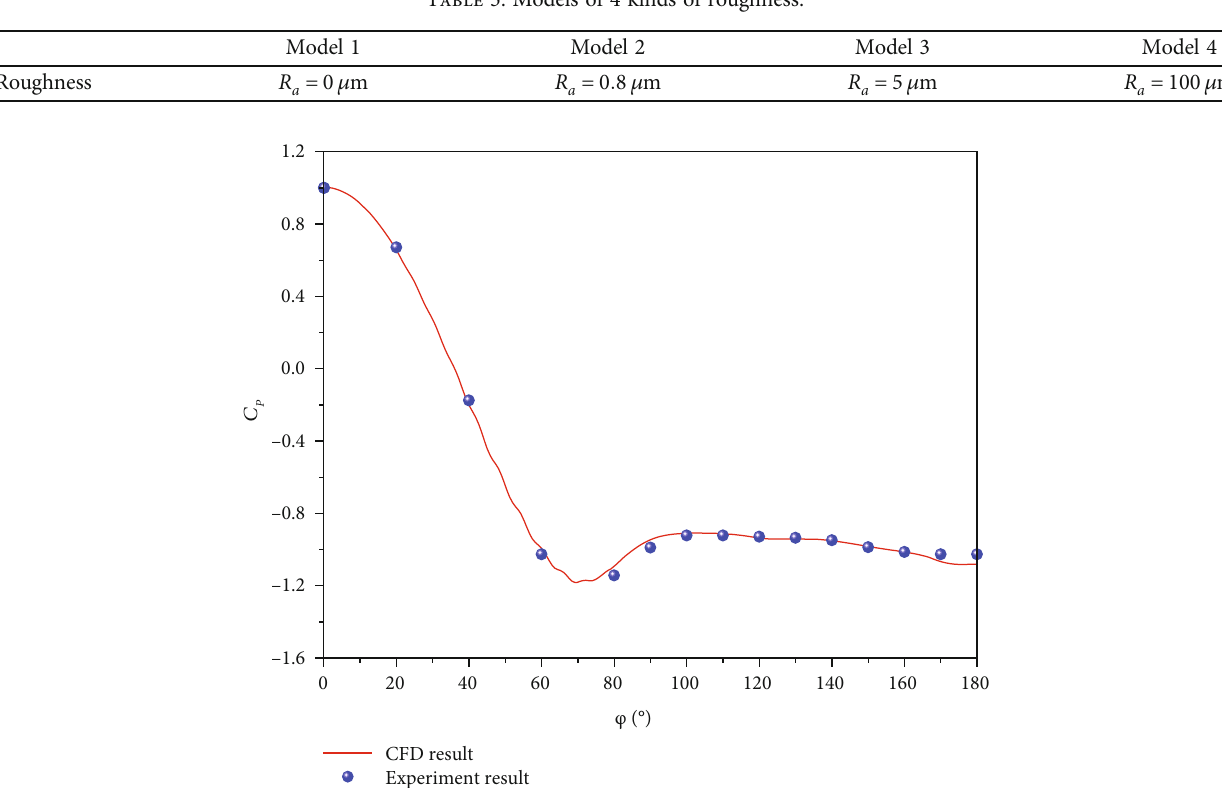
Table 3: Models of 4 kinds of roughness.